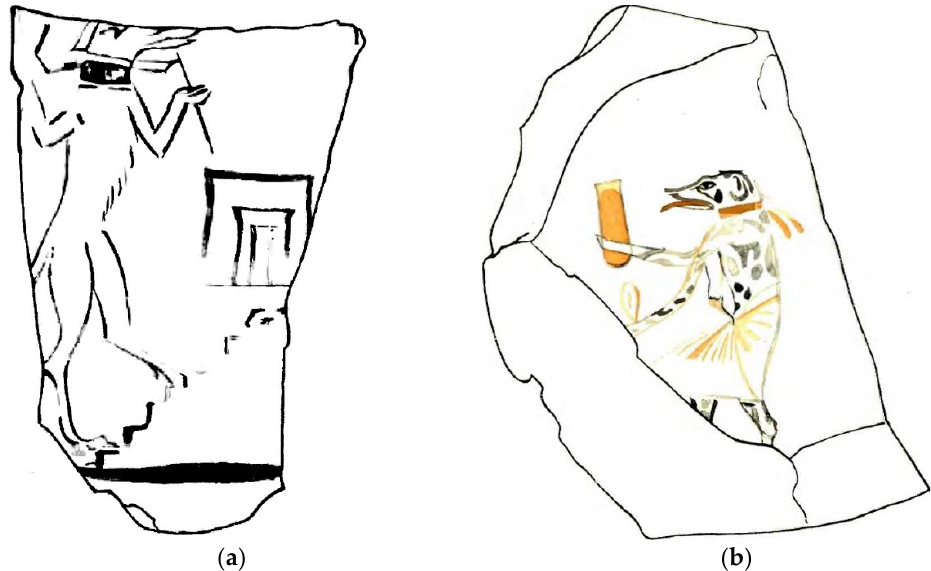
Figure 11. Dogs visiting a temple (IFAO inv. no. 3666 and no. 3508), limestone flakes, Deir el-Medina, Ramesside period (Line drawing taken from Vandier d’Abbadie (1937), pl. 48, courtesy of the Institut Français d’Archéologie Orientale, Cairo) ( a , b ).